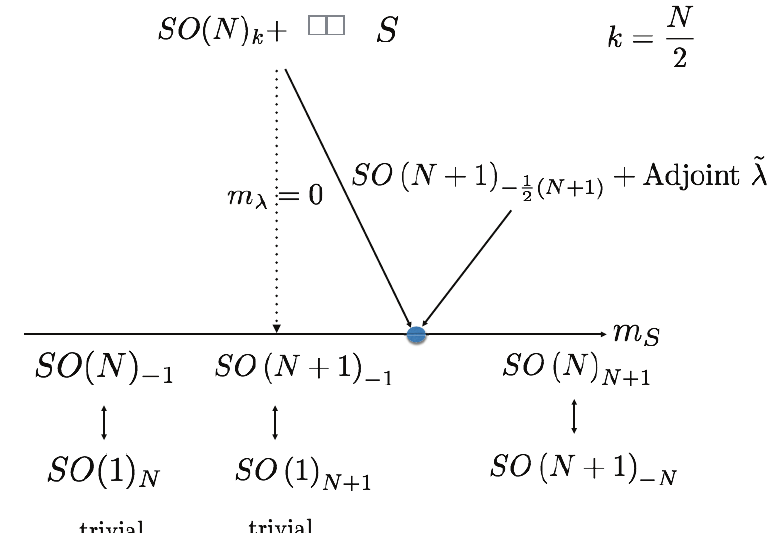
Figure 18: The phase diagram of SO ( N ) gauge theory with a fermion in a symmetric- k traceless tensor for k = N . There is one transition that connects a nontrivial TQFT 2 and a trivial one. We propose a fermionic dual for the nontrivial transition.